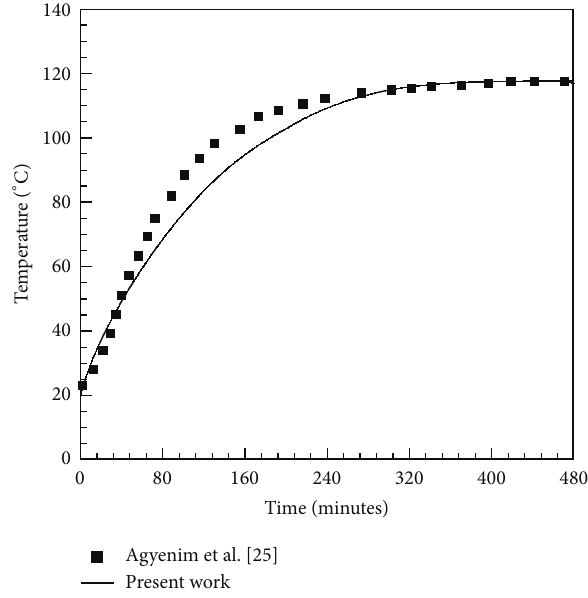
Figure 3: Comparison of average temperature profile in the PCM versustimebetweenthepresentstudyandAgyenimetal.’swork[25].